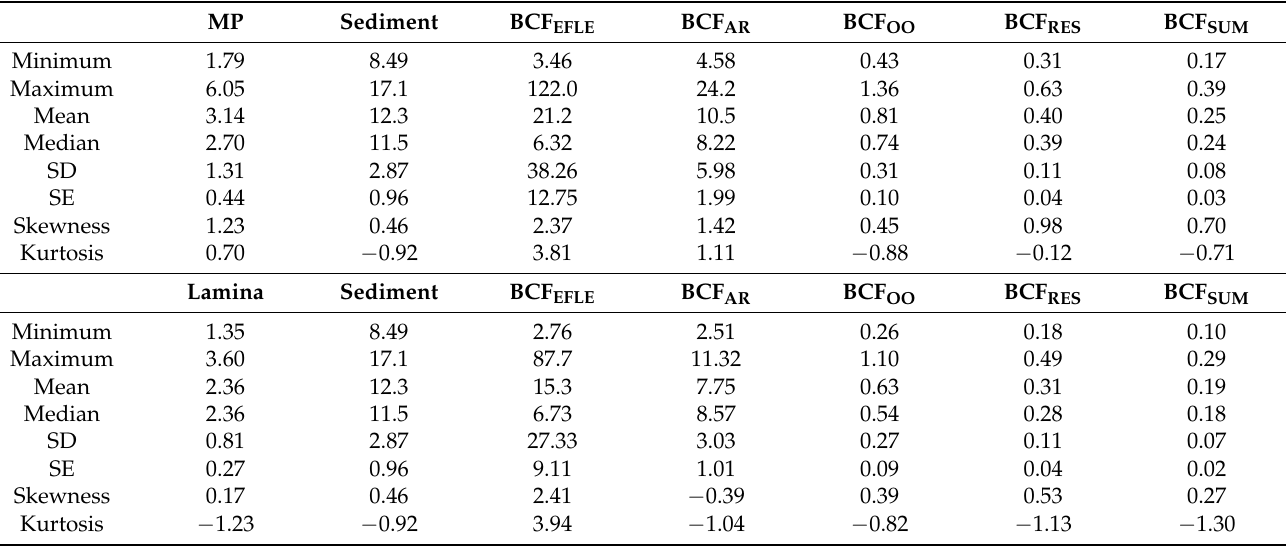
Table 9. Overall statistics of Ni concentrations (mg/kg dry weight) in the midrib plus petiole (MP), and lamina of Rhizophora apiculata , with their habitat geochemical fractions of sediments and their bioconcentration factors (BCF) values, collected from nine sampling sites in the mangrove areas of Sepang and Lukut. N =